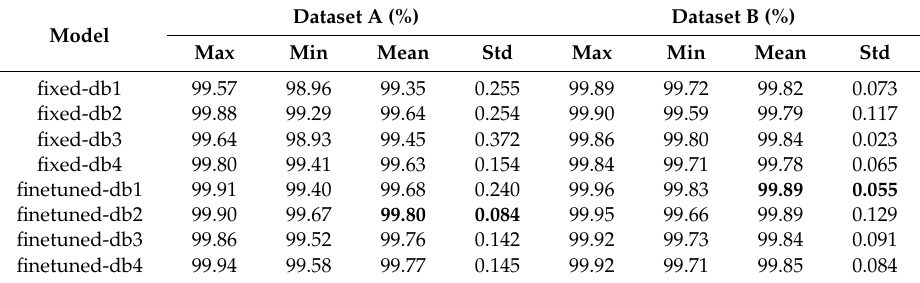
Table 11. Testing results of di ff erent model setups on two datasets in Case Two.